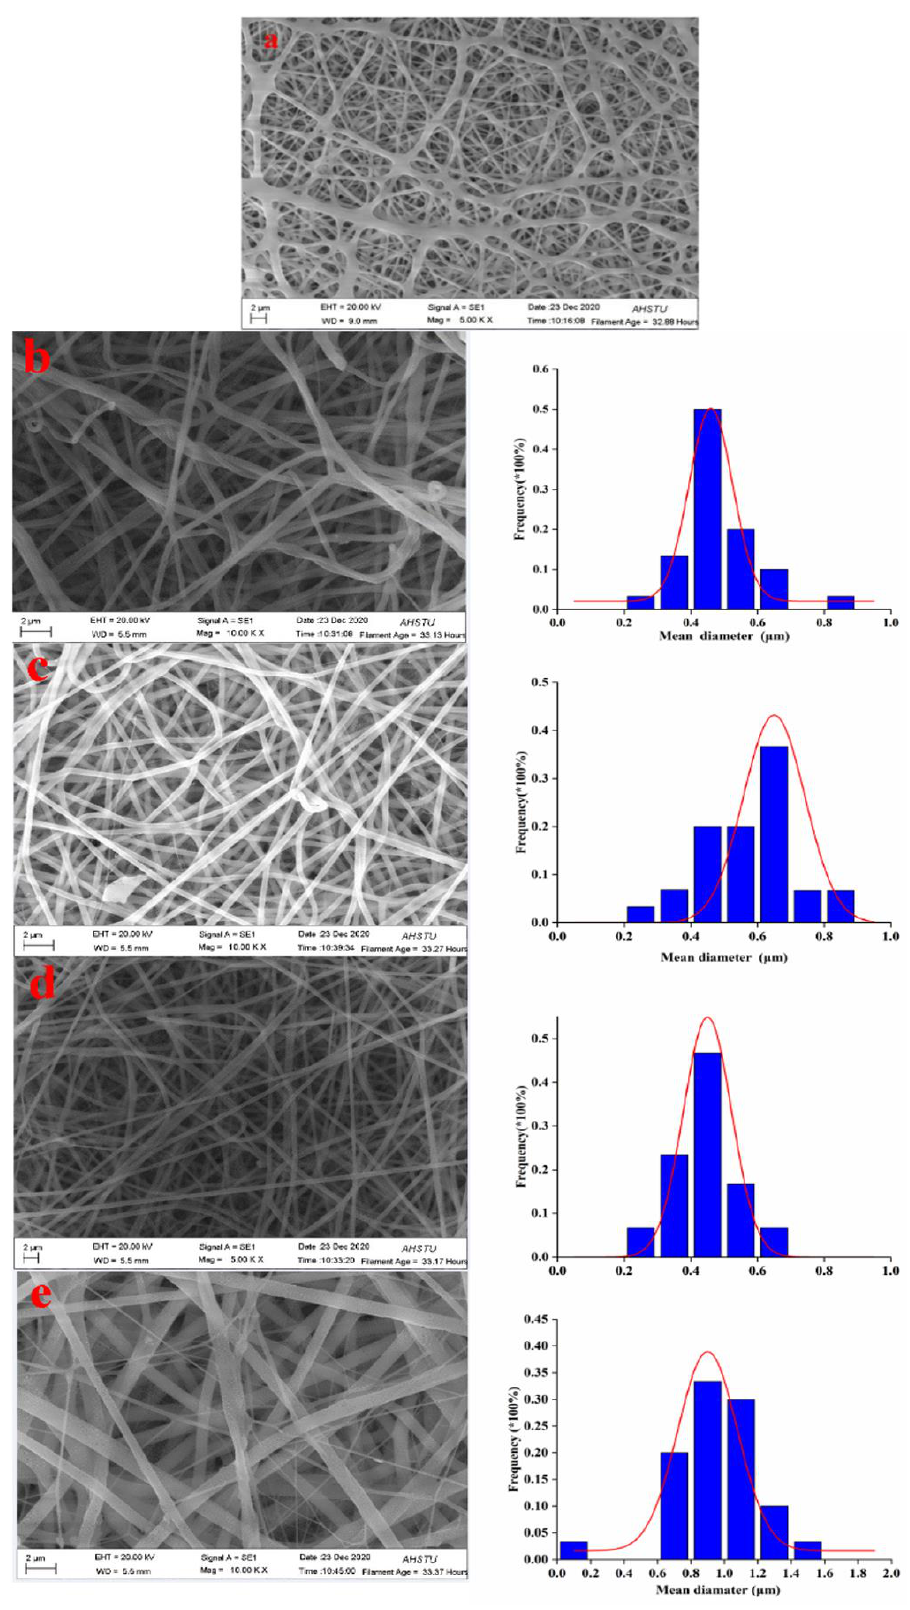
Figure 3. SEM images and diameter distributions of: ( a ) 12% nylon6 nanofiber membrane; ( b ) 12% nylon6/2% pig nail keratin composite; ( c ) 12% nylon6/4% pig nail keratin composite; ( d ) 12% nylon6/6% pig nail keratin composite; and ( e ) 12% nylon6/8% pig nail keratin composite.